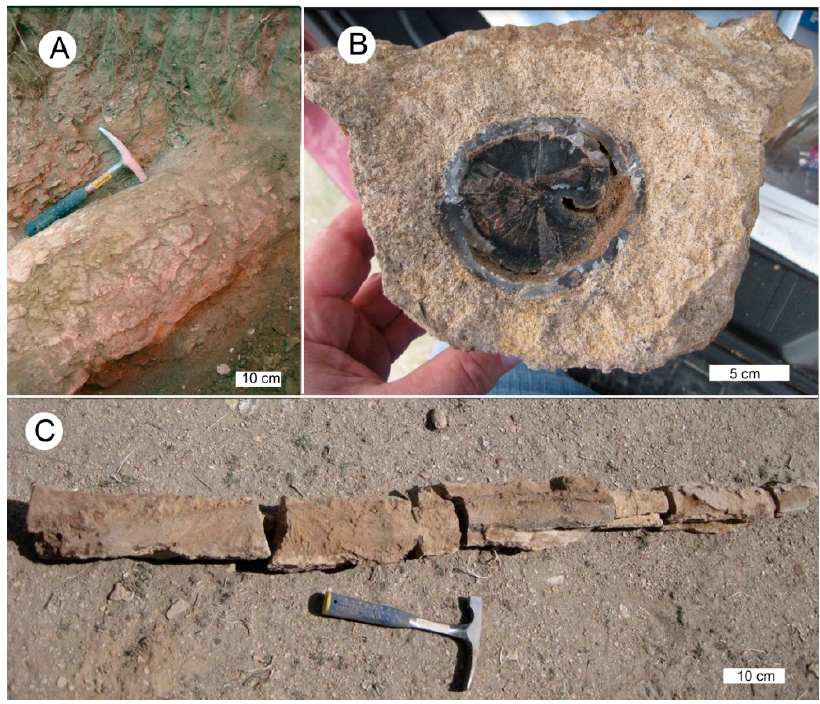
Figure 6. Freshly-excavated Blue Forest specimens. ( A ) Log coated with silicified biogenic calcareous material. ( B ) Limb surrounded by a stromatolitic layer. ( C ) Slender limb, fractured during excavation. Photos by Mike Viney, 2018.